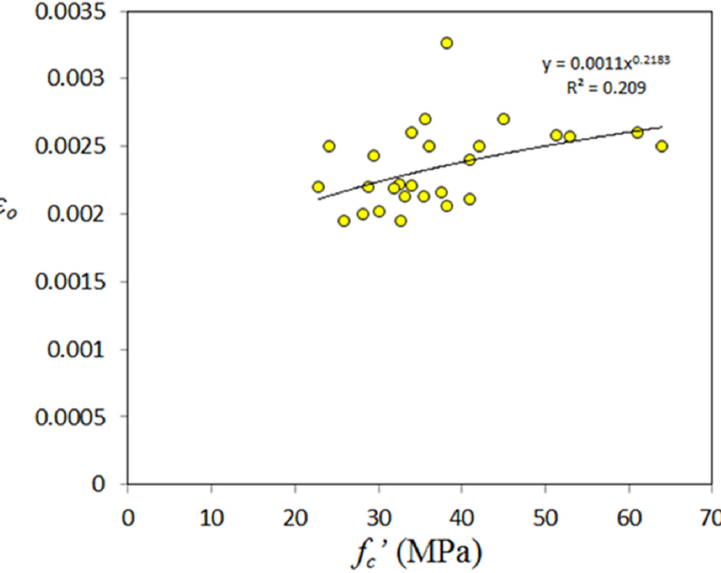
Figure 16. Variation of strain corresponding to peak stress with compressive strength of GPC.